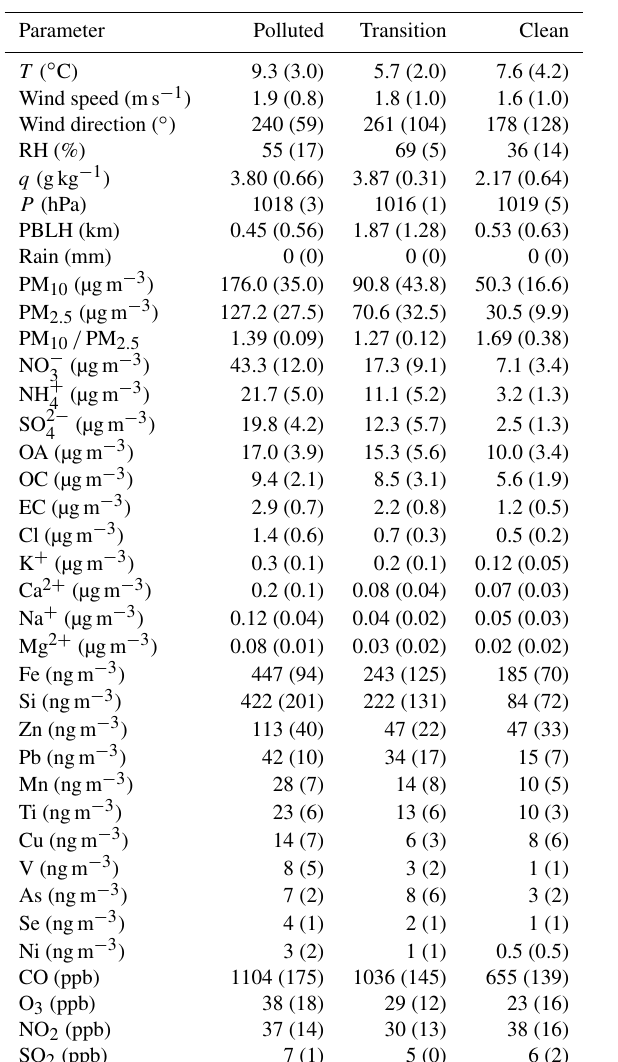
Table 4. Average meteorological, aerosol, and gas parameters for the polluted, transition, and clean time periods measured at the Seoul sampling site, with standard deviations shown in paren- theses. Note that organic aerosol (OA) concentration was calcu- lated by multiplying the OC concentration by a factor of 1.8 (i.e., OA = OC × 1.8).